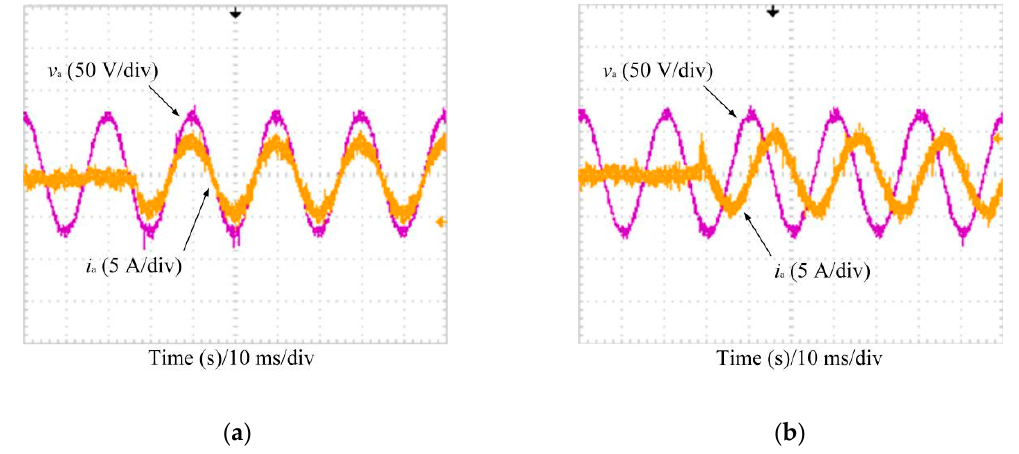
Figure 22. System dynamic response: ( a ) a -phase voltage and a -phase current of the AC side in active power compensation mode; and ( b ) a -phase voltage and a -phase current of the AC side in reactive power compensation mode.